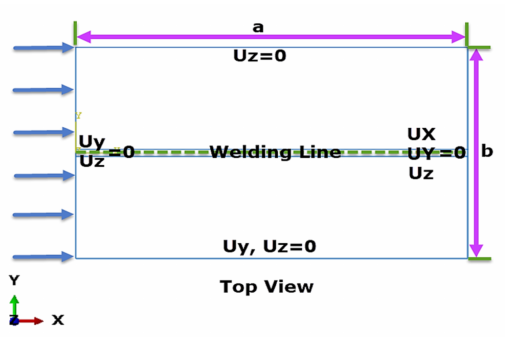
Figure 5. Geometrical properties and BCs for the ultimate strength calculations.